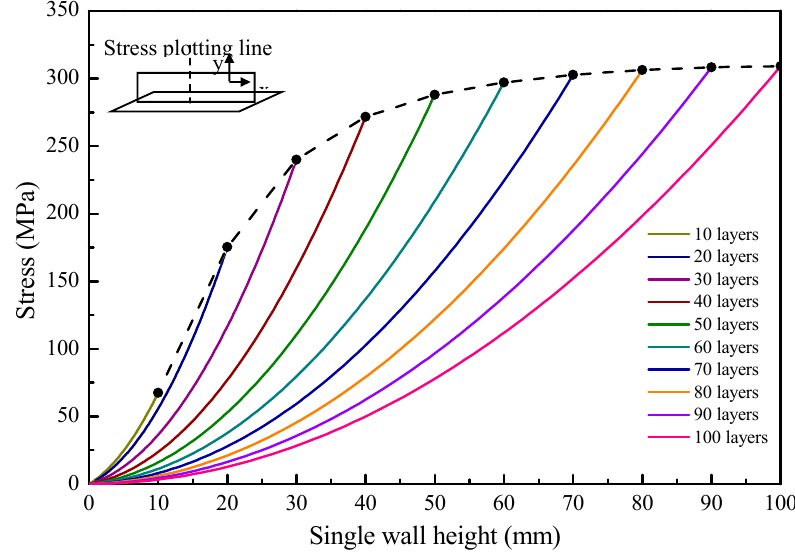
Figure 6. Stress distributions along central plot line during additive manufacturing